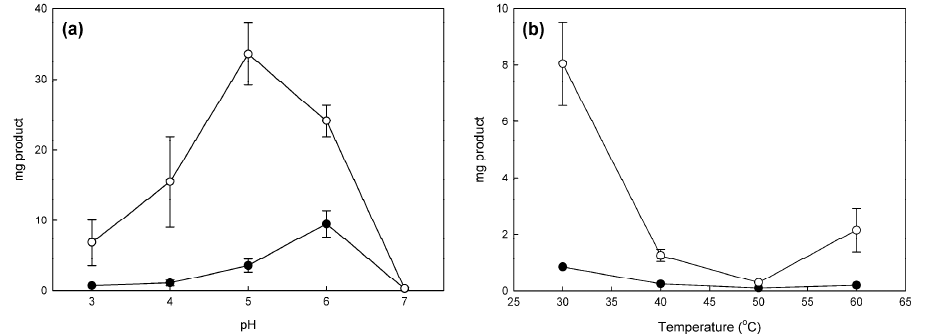
Figure 1. Effect of ( a ) pH and ( b ) temperature in polymerization reactions of catechol ( black circles ) and pyrogallol ( white circles ) from M. thermophila laccase under standard conditions performed in 25 mL reactions. Error bars represent the standard deviation from duplicate reactions.